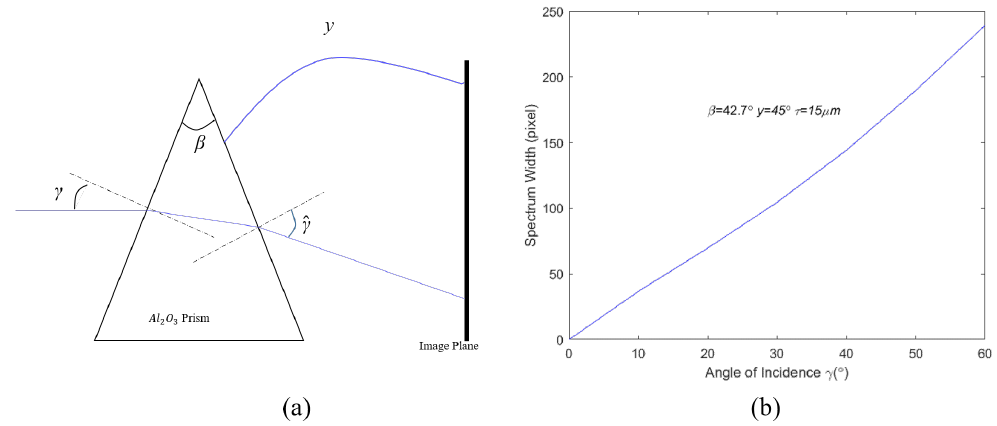
Figure 13. ( a ) Optical path in the AL 2 O 3 prism: β denotes the prism angle, γ denotes the incident angle, y denotes the angle of the prism’s surface with the imaging plane, and ˆ γ denotes the outgoing ray angle. ( b ) Spectrum width in our proposed system with a different incident angle γ